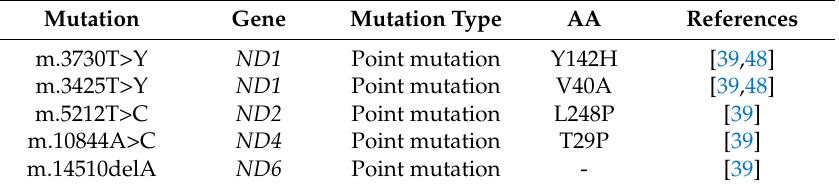
Table 3. Mitochondrial DNA mutations in complex I genes associated to deficit of complex